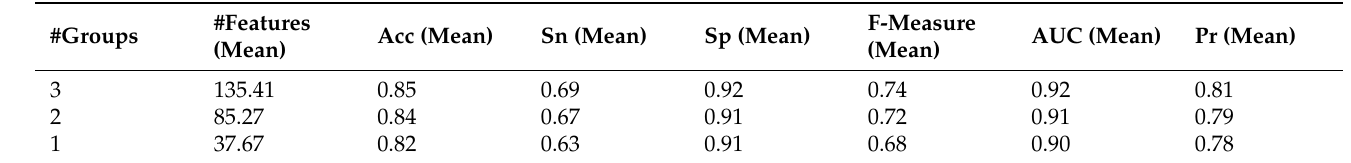
Table 5. Performance results of the AMP-GSM approach for the Gram-positive dataset of Dataset 1 without using physico-chemical properties (for 11 groups and 100-fold MCCV)